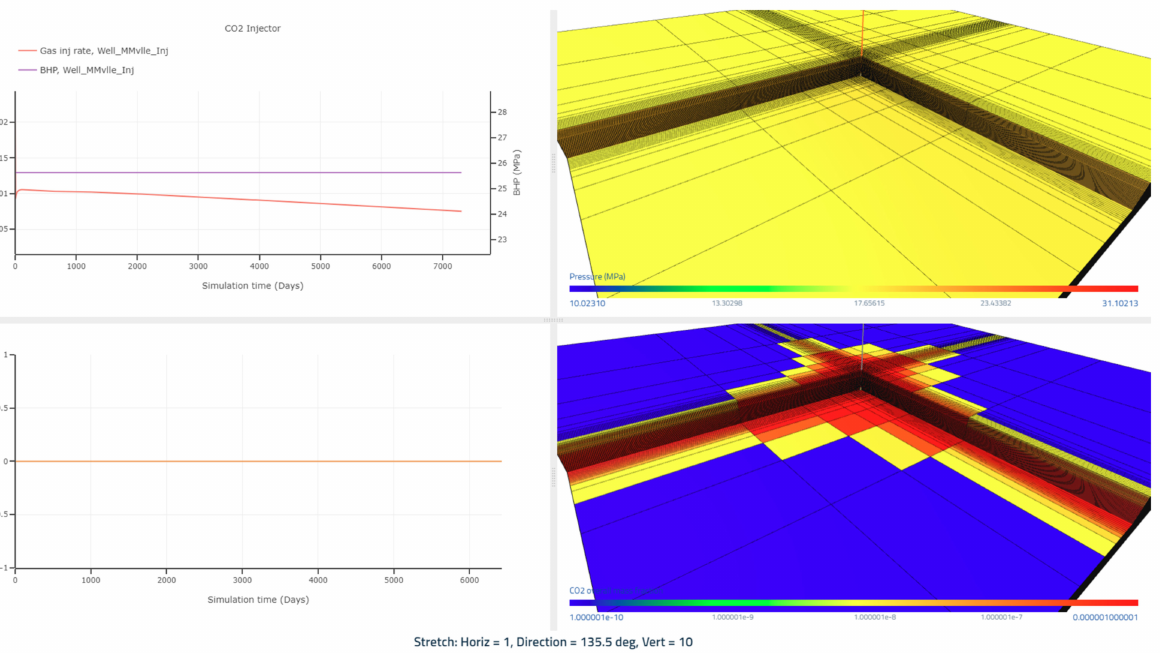
Figure 6. ResFrac™ model output for the case of CO 2 injection into the Middle Mannville Formation for a 20-year period (with a bottomhole pressure limit of 90% of σ hmin ). Upper left: bottomhole pressure and gas injection rate. Lower left: fracture surface area generated. Upper right: reservoir pressure at Year 20. Lower right: CO 2 mass fraction in the model domain at Year